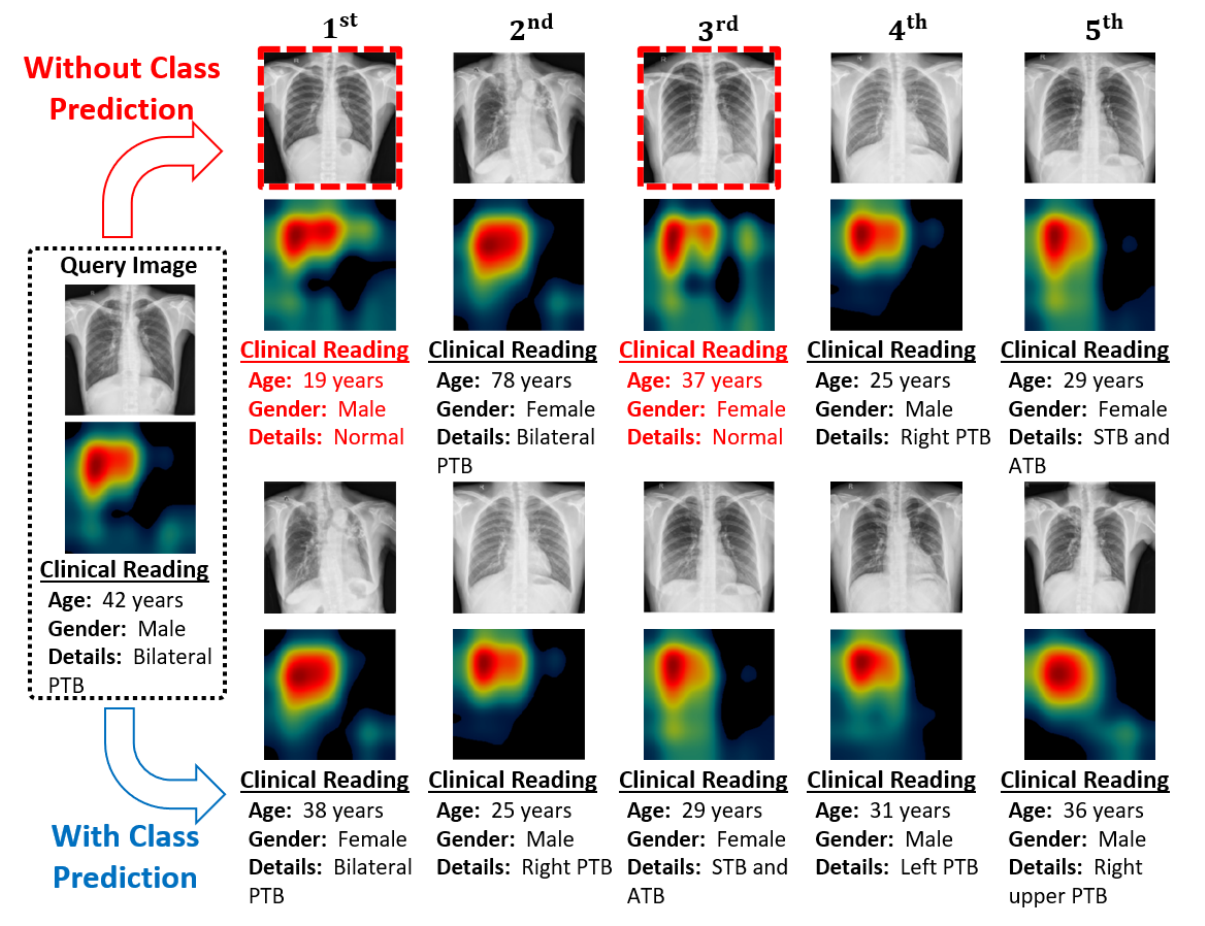
Figure 10. Visualization of retrieval performance for the given input query image by considering both retrieval methods with class prediction and without class